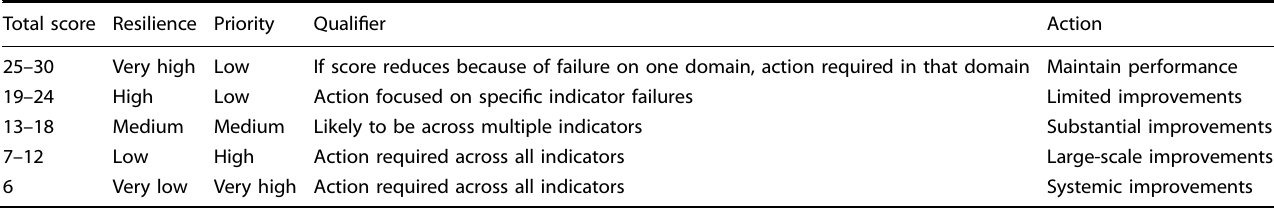
Table 4. Total resilience scores.